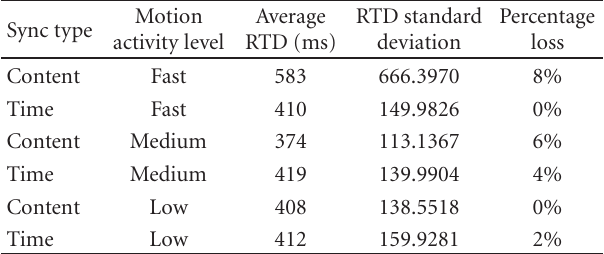
Table 2: RTD and percentage of packet loss